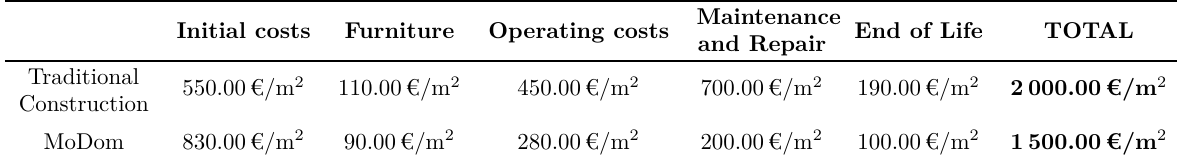
Table 1. A Quantity of Life Cycle